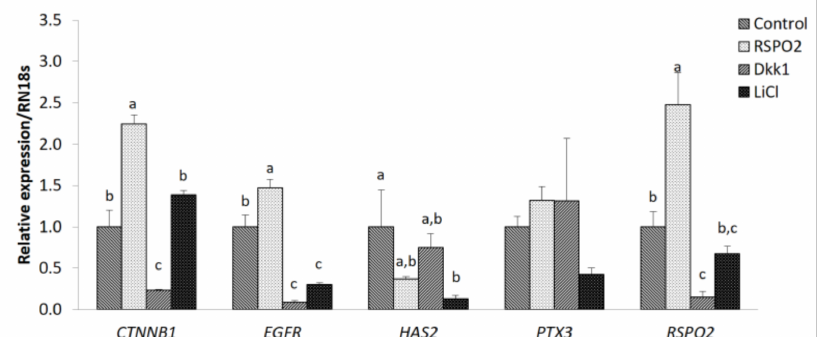
Figure 5. Expression levels of genes relative to cumulus cell expansion and RSPO2-WNT signaling were determined by qPCR. Mean ± SEM expression of CTNNB1 , EGFR , HAS2 , PTX3 , and RSPO2 mRNA in cumulus cells. Each gene was isolated and statistically analyzed. Within each end point, bars with different letters (a, b and c) are significantly ( p < 0.05) different. The experiment was replicated